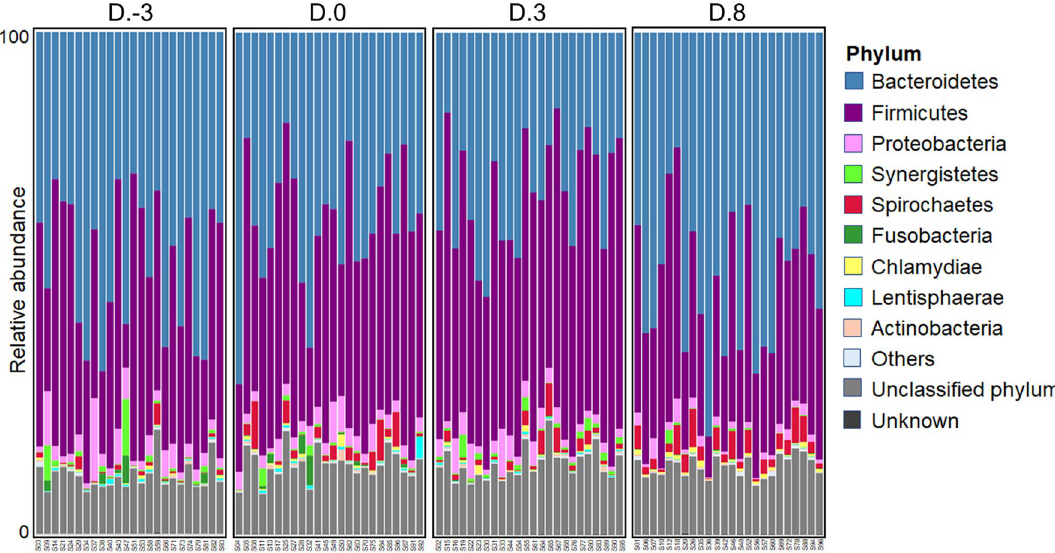
Figure 1. Stacked bar plot showing taxonomic relative abundance distribution of fecal microbial communities at the phylum level of piglets, with samples sub-categorized by maternal litter and age at day 3 pre-weaning (D. − 3), weaning day (D.0), days 3 (D.3) and 8 post-weaning